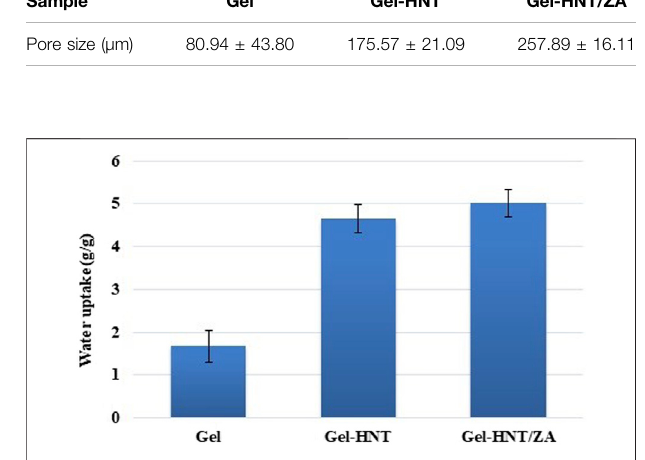
FIGURE 2 | Equilibrium water uptake values of the